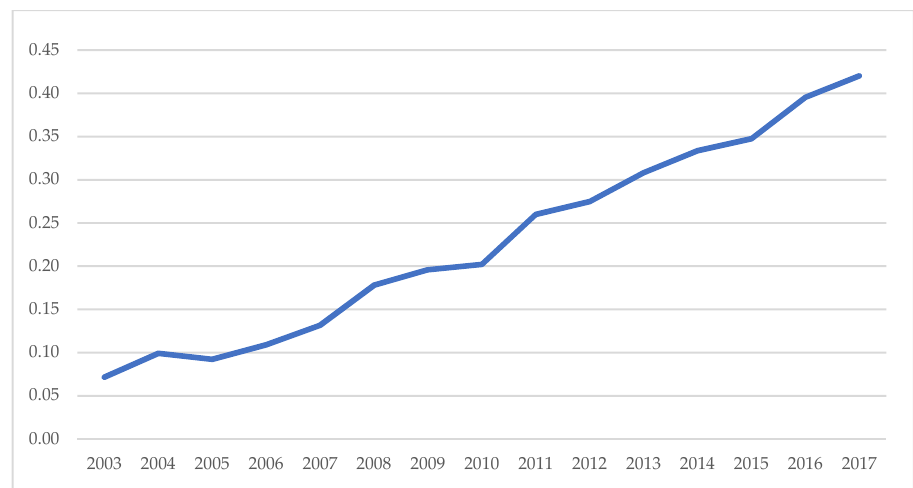
Figure 4. 2003–2017 price index (data source: China National Bureau of Statistics).